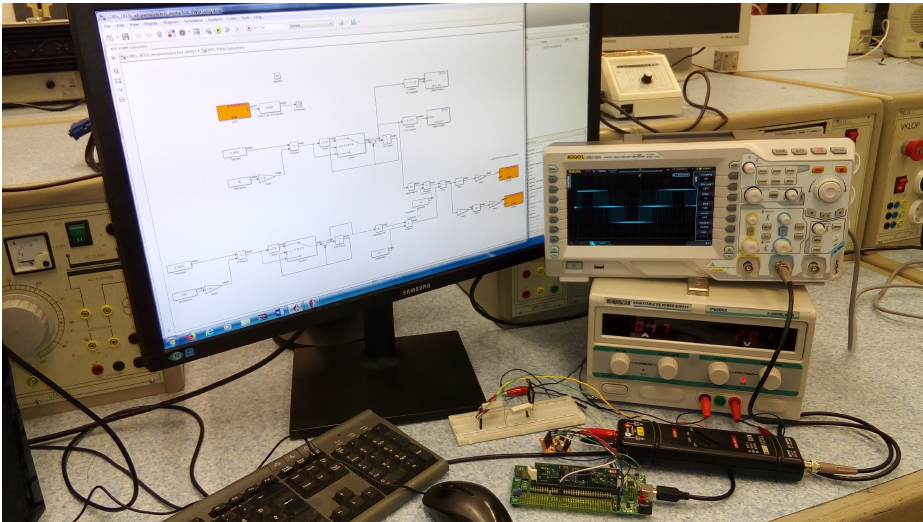
Figure 10. Experimental setup.